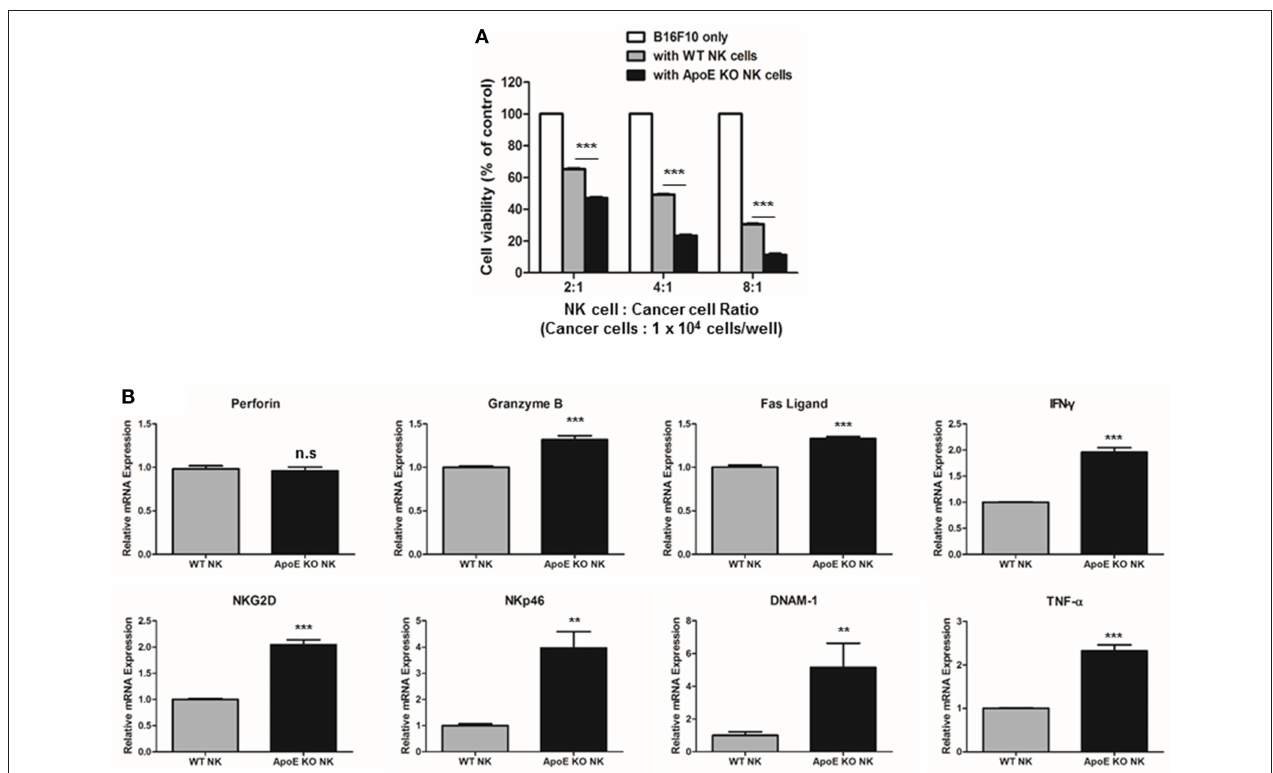
FIGURE 5 | Effect on ApoE KO on NK cell-mediated cytotoxicity. (A) NK cell cytotoxicity was determined using LDH assay co-cultured with WT or ApoE KO NK cells and B16F10 target cells for 4h (1 × 10 4 cells/well). (B) Perforin, Granzyme B, Fas L, TNF- α , IFN- γ , NKG2D, NKp46, and DNAM-1 mRNA expressions in WT or ApoE KO NK cells were determined by qPCR ( n = 3). ** p < 0.01 and *** p <